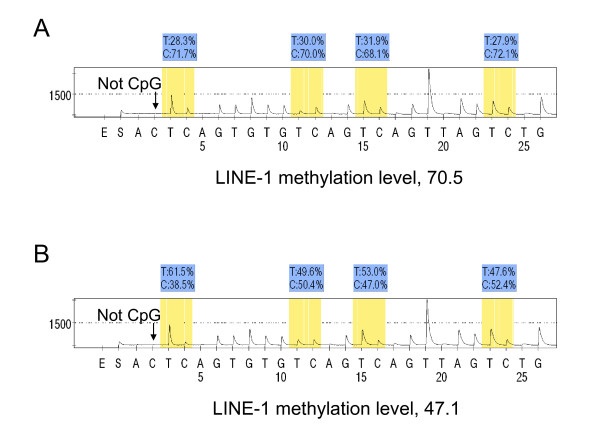
Pyrosequencing to measure LINE-1 methylation. A. LINE-1 hypermethylated tumor. B. LINE-1 hypomethylated tumor. The % numbers (in blue shade) are proportions of C and T at each CpG site after bisulfite conversion, and the methylation level of each CpG site is estimated by the proportion of C (%). An overall LINE-1 methylation level is calculated as the average of the proportions of C (%) at the 4 CpG sites. The first, third and fourth CpG sites follow mononucleotide T repeats, resulting in higher T peaks (in yellow shade) than the second CpG site, and the proportion of C (%) has been adjusted accordingly. The arrows indicate no residual C at the non-CpG site, ensuring complete bisulfite conversion.